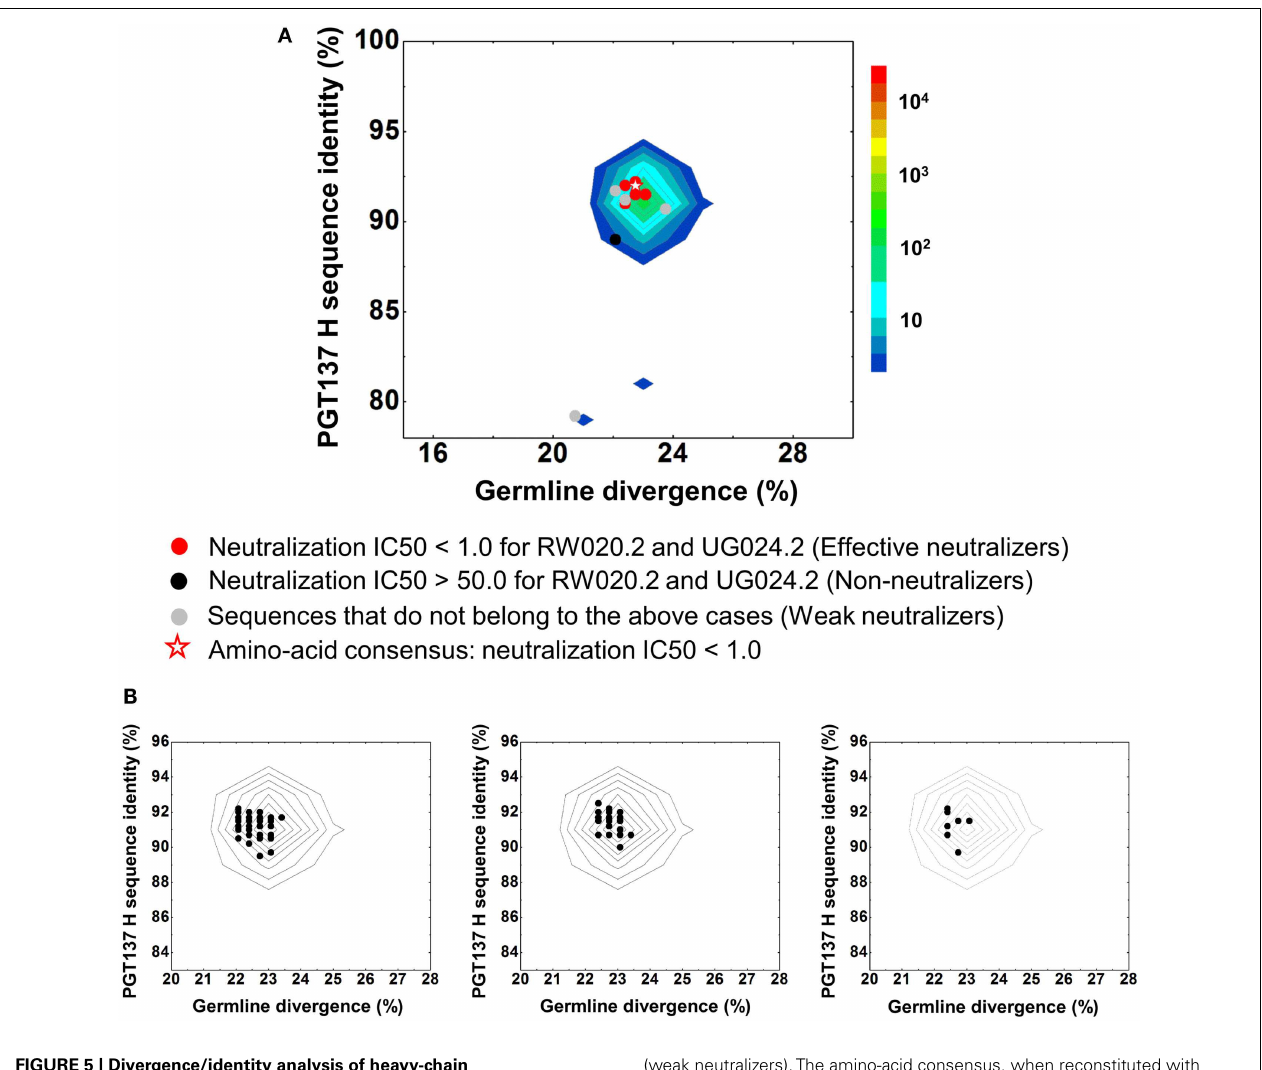
FIGURE 5 | Divergence/identity analysis of heavy-chain neutralization. (A) The expressed heavy-chain sequences color-coded based on the neutralization potency of reconstituted antibodies, with IC50 < 1.0 for both viruses shown in red (effective neutralizers), IC50 > 50.0 for both viruses in black (non-neutralizers), and other cases in gray